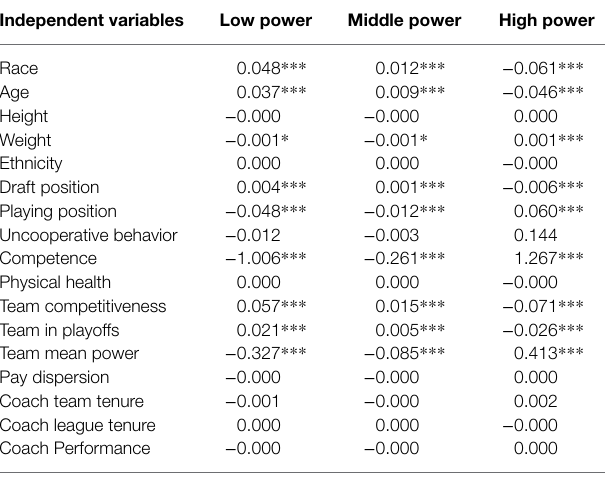
TABLE 4 | Marginal effects of the pooled ordered probit model on the probability of power. Independent